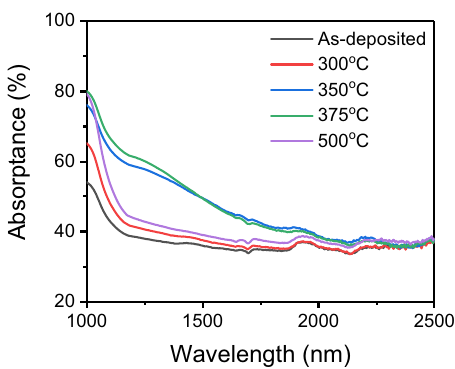
Fig. 7 Optical absorptance spectra of as-deposited and annealed SnGe samples. The as-deposited sample and the samples annealed at 300 and 500 °C have no or little α -Sn, while those annealed at 350 and 375 °C have substantial amount of α -Sn, leading to characteristic optical absorption at 1250 – 1750 nm